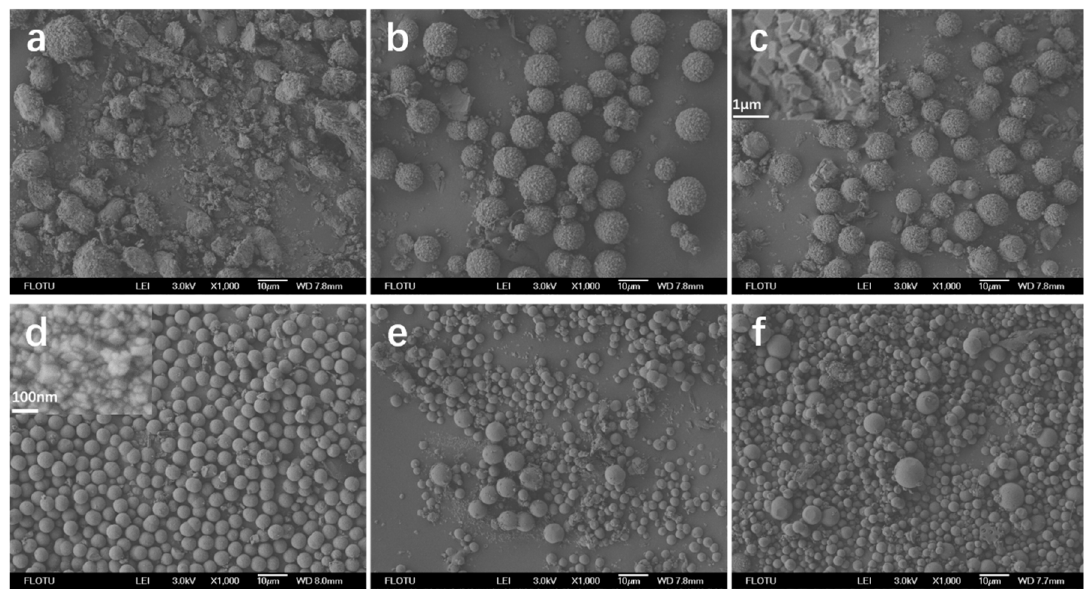
Figure 5. SEM images of the products after hydrothermal treatment in ammonia carbonate of different concentration ( C (NH4)2CO3 ). ( a ) 0 mol·L − 1 ; ( b ) 0.05 mol·L − 1 ; ( c ) 0.10 mol·L − 1 ; ( d ) 0.15 mol·L − 1 ; ( e ) 0.25 mol·L − 1 ; ( f ) 0.30 mol·L − 1 . R M = 1:1:1 (Ni:Co:Mn); T h = 180 °C; and t h = 24 h.